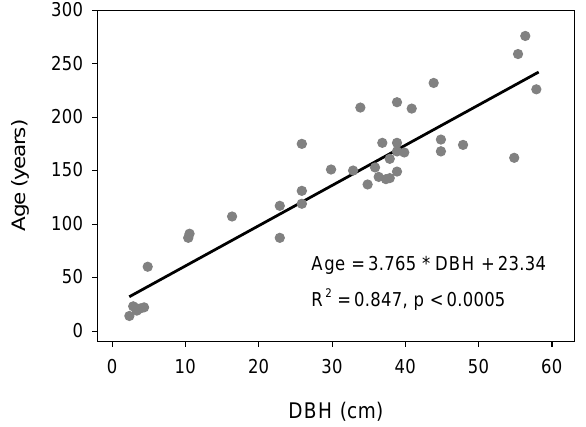
Figure 3. Diameter at breast height (DBH) versus age of Betula utilis from the Kalchuman Lake area, Manaslu Conservation